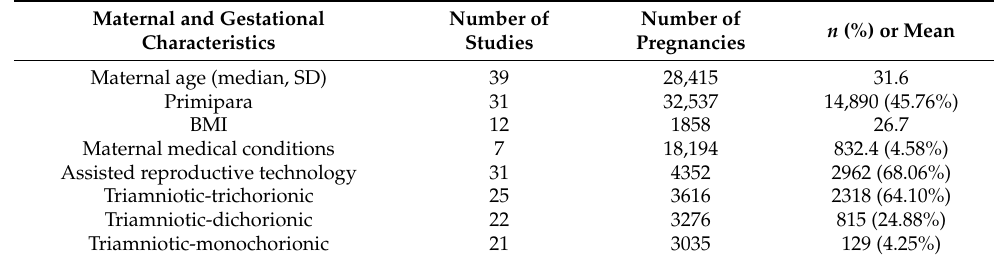
Table 2. Maternal and gestational characteristics of the triplet pregnancies included in the systematic review.